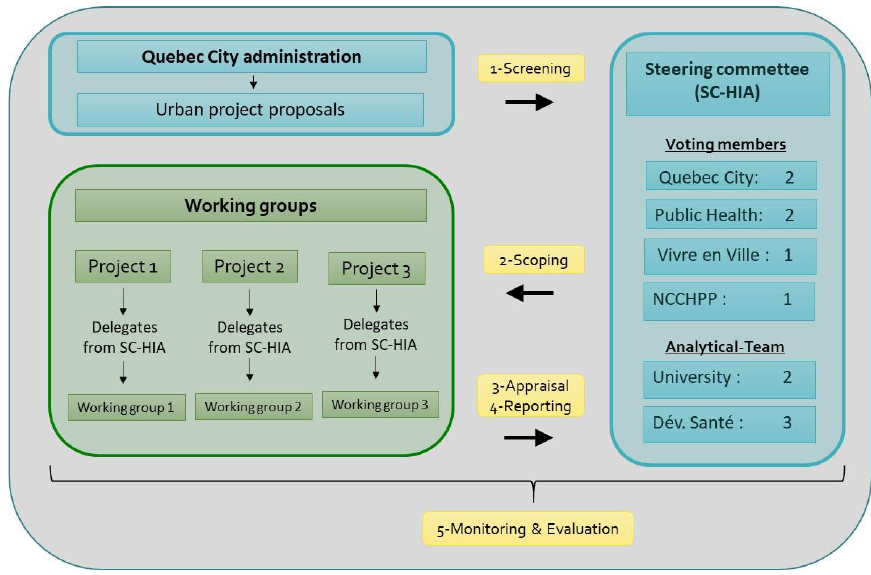
Figure 2. Approach for Health Impact Assessment (HIA) implementation into the urban planning process in Quebec City.